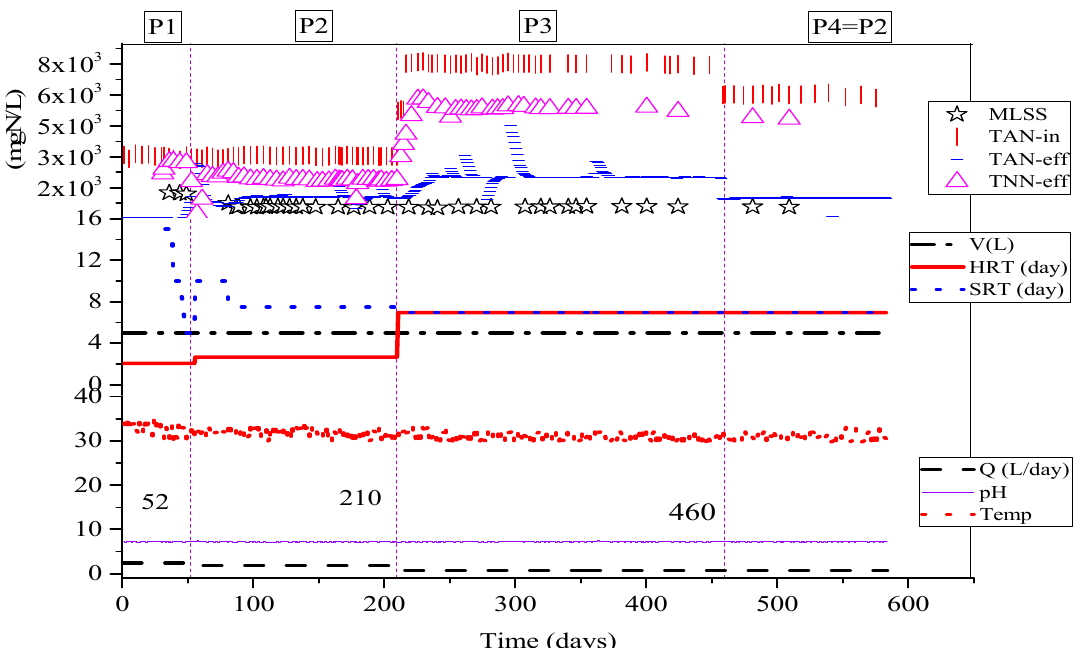
Figure 1. Daily performance of continuous stirred tank reactor (CSTR) (A) from phase 1 to phase 8.